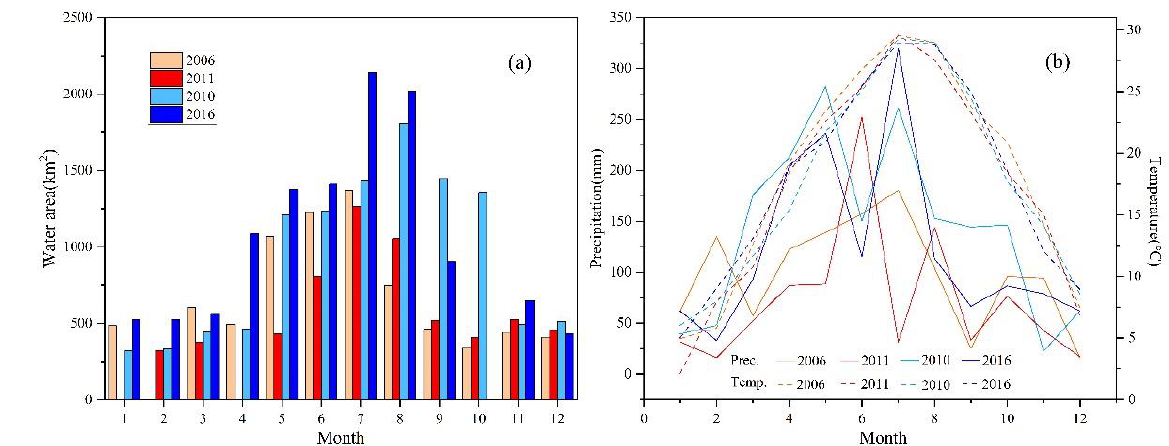
Figure 11. The monthly water area ( a ) and precipitation and temperature data ( b ) for 2006, 2011, 2010 and 2016.